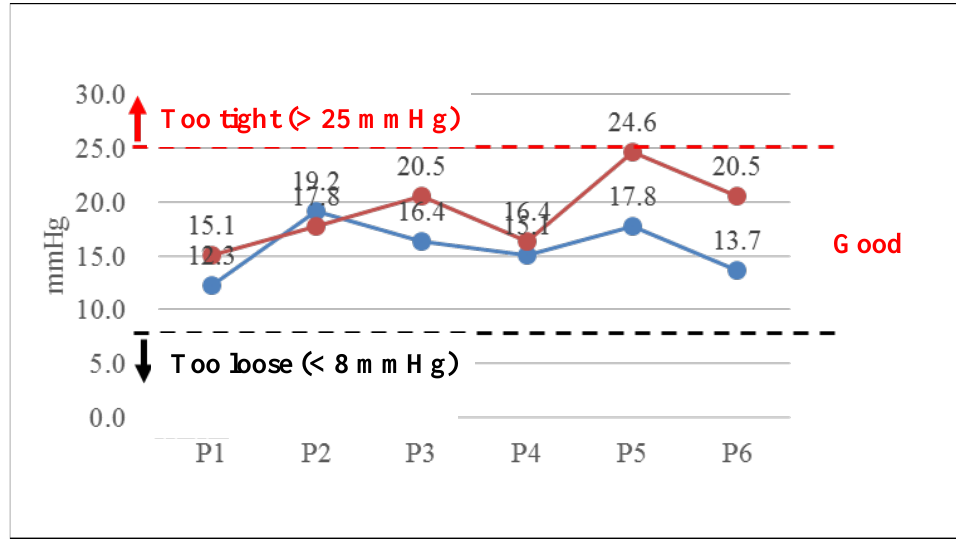
Figure 7. The pressures of P1-P6 when attending physicians and resident applying a short arm cast. The difference of the pressure values measured from P1 to P6 of the simulated arm 22.8%, − 7.3%, 25.0%, 8.6%, 38.2%, 49.6%, respectively, in the experiment. It showed that styloid, was maximal. These two points were the most protruded bones. It was also the location of a pressure sore